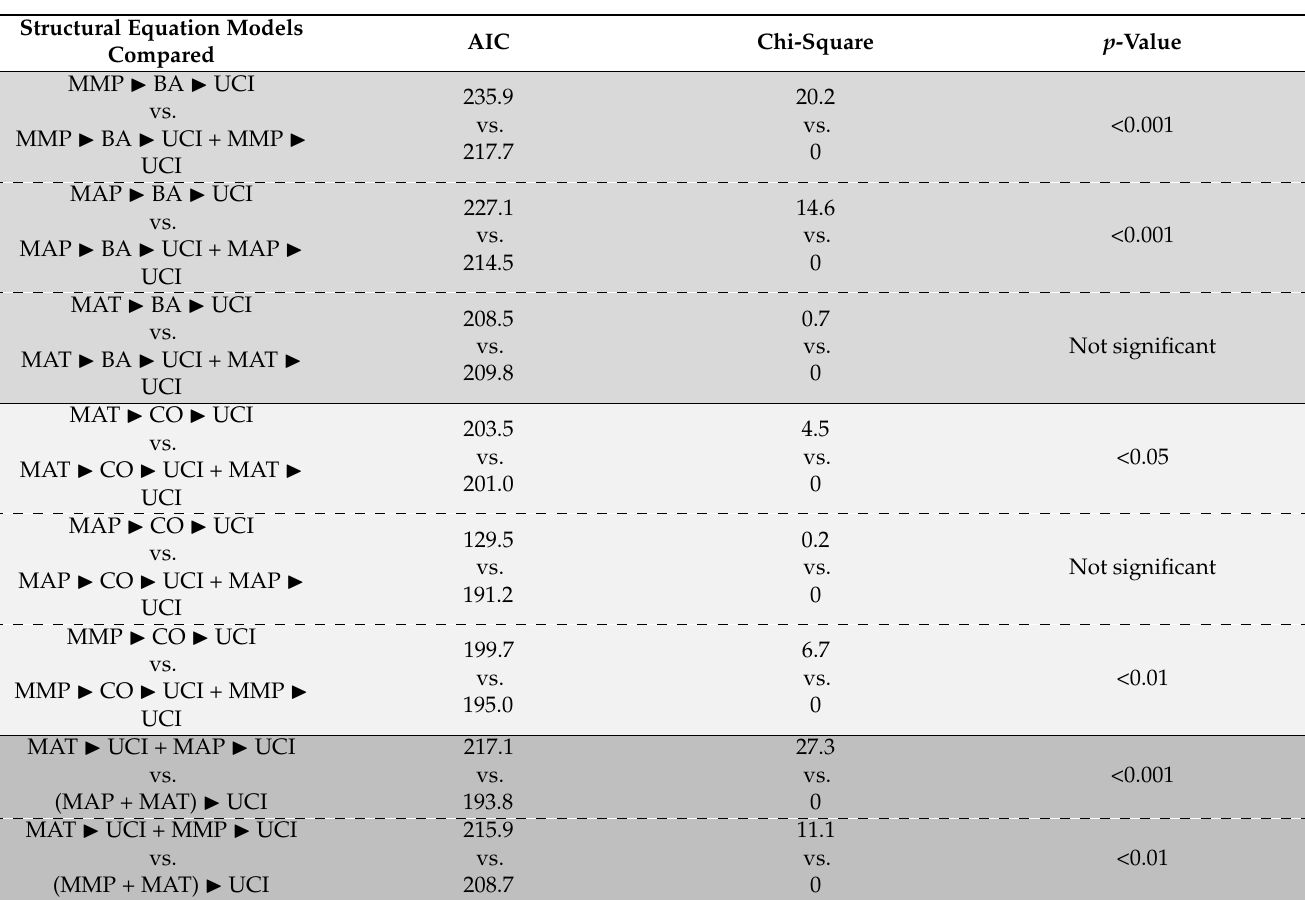
Table 3. Summary of the major properties of the compared structural equation models. Note: in every model we also used a latent variable for the error (soil differences, etc.) not shown in the first column. Brackets in the first column indicate that two variables were considered with their combined effect. The “ (cid:73) ”-symbol indicates “effect of x on y”. MAT = mean annual temperature; BA = basal area; UCI = understory complexity index; MMP = mean precipitation during driest month; CO = canopy openness; AIC = Akaike information criterion. Structural Equation